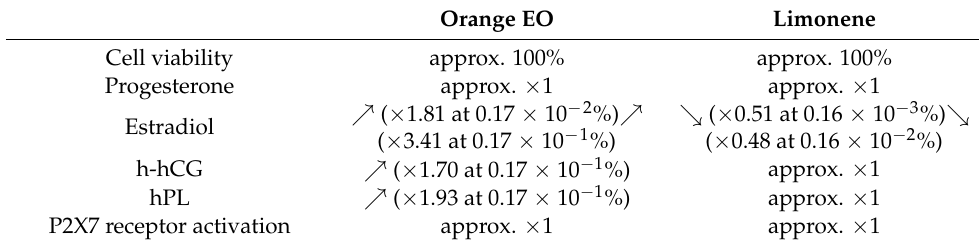
Table 3. Summary of the results of orange EO compared to limonene. Orange EO Limonene Cell viability approx. 100% approx. 100% Progesterone approx. × 1